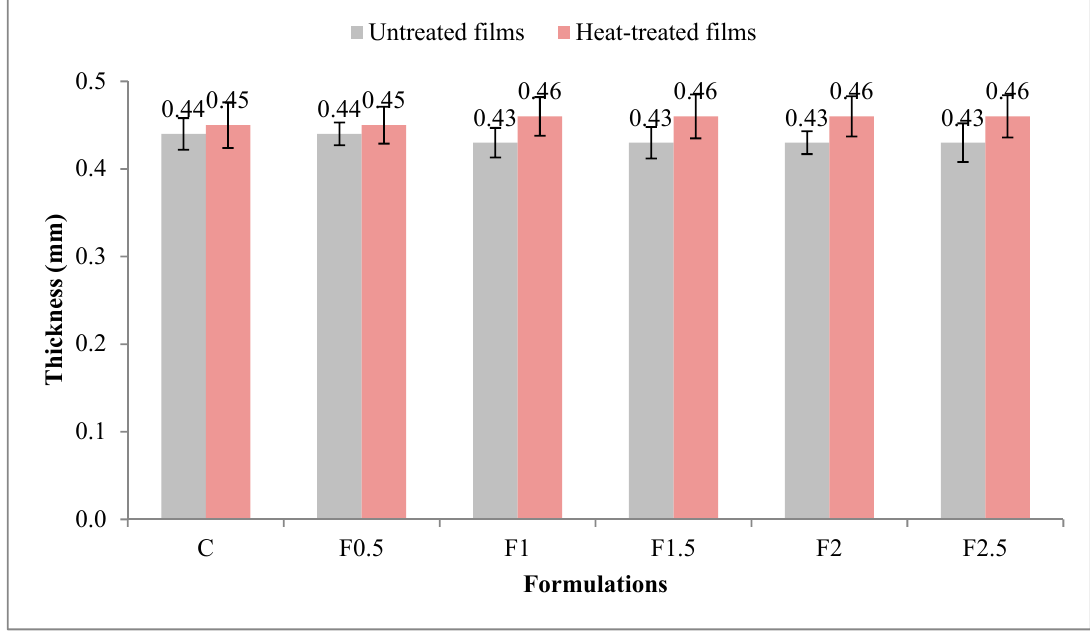
Figure 2. Variation in film thickness with heat treatment and formulation. C-control film; F0.5-film with 0.5% tarragon essential oil; F1-film with 1% tarragon essential oil; F1.5-film with 1.5% tarragon essential oil; F2-film with 2% tarragon essential oil; F2.5-film with 2.5% tarragon essential oil. Values are expressed as mean ± standard deviation of 24 replicates.